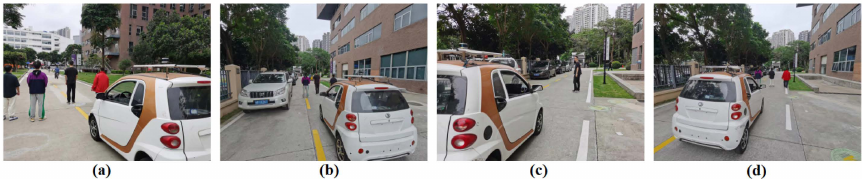
Figure 20. Person-following roboplatform in outdoor world. ( a ) Following the target in black clothing on Road-1; ( b ) Following the target in crowded and occluded scenario on Road-2; ( c ) Continue following the target on Road-3 in varying pose; ( d ) Continue following the target on Road-3 even even there are distractor and impostor.